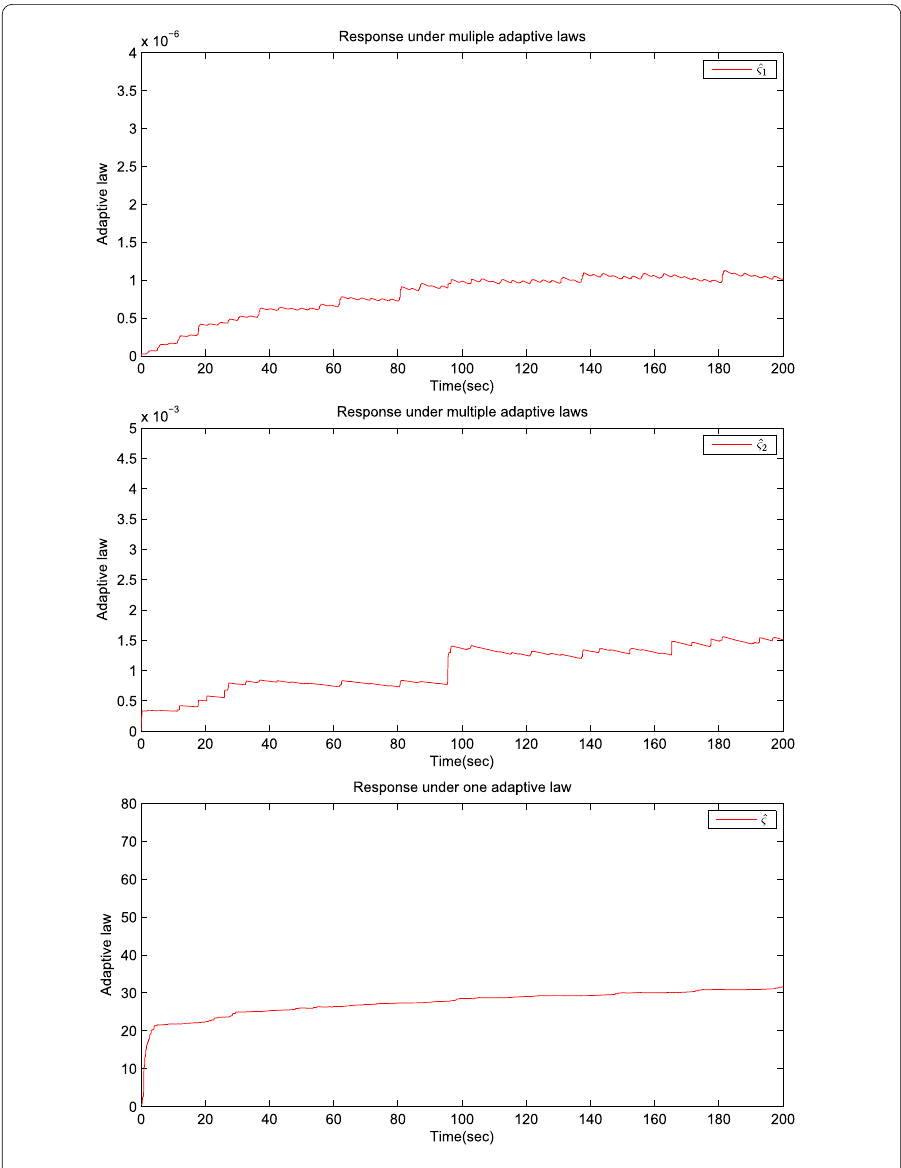
Figure 3 Responses of the adaptive laws of Example